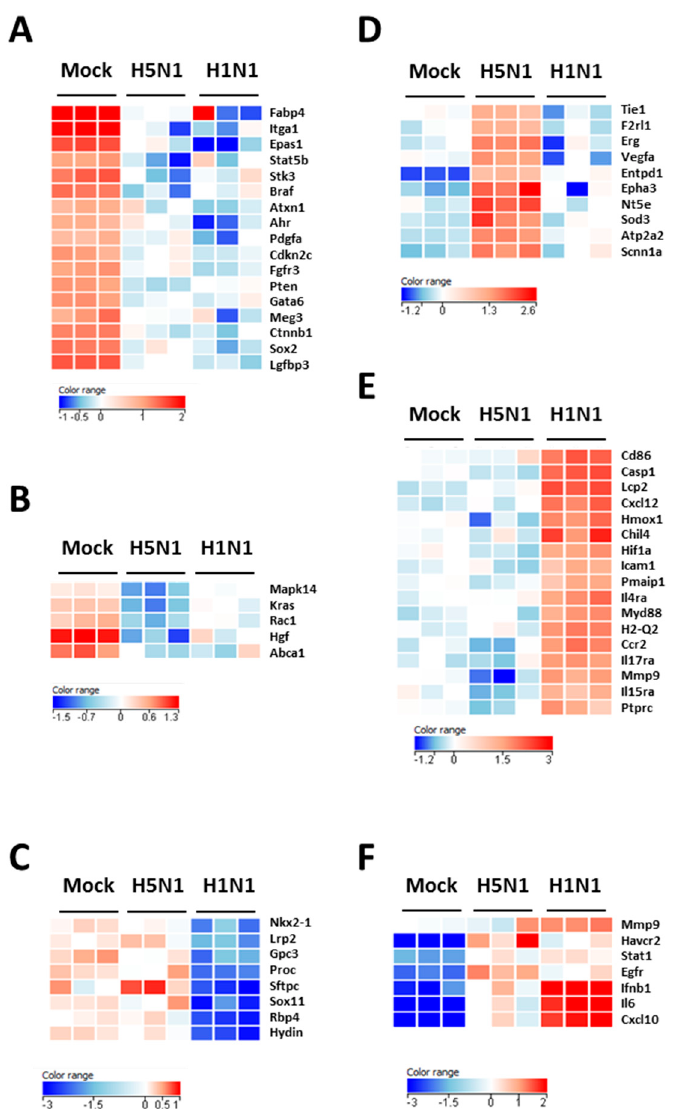
Figure 3. Heat maps of selected genes in the lungs of mock- H1N1- and H5N1-infected mice at day 4 pi. Representative genes of each cluster were selected and represented as a heat map. Genes shown in red are upregulated and genes in blue are downregulated. The magnitude of the regulation is illustrated by the intensity of the color. ( A ) Heat map of genes from cluster 1 and related to growth of epithelial tissue. ( B ) Heat map of genes from cluster 2 and related to quantity of AT2 cells. ( C ) Heat map of genes from cluster 3 and related to respiratory system development. ( D ) Heat map of genes from cluster 4 and related to edema of lung. ( E ) Heat map of genes from cluster 5 and related to inflammation of lung. ( F ) Heat map of genes from cluster 6 and related to infection of lung.